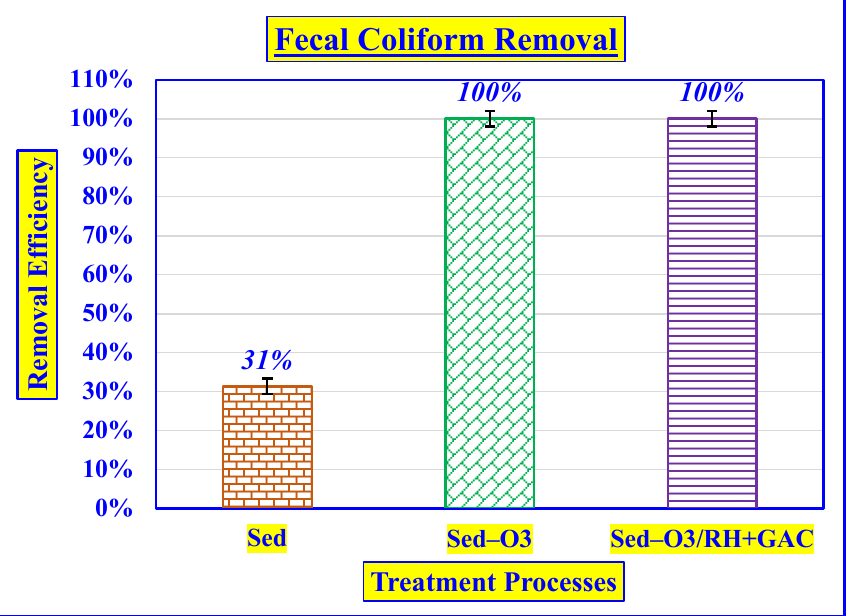
Figure 10. Fecal Coliform removal by hybrid system (Initial Fecal Coliform = 5170 MPN/100 mL; O 3 = 82.5 ± 2.2 mg/L; peristaltic pump speed = 150 rpm; C.T = 18 min; GAC = 200 g; RH = 200 g; pH = 6.9 ± 0.2; volume = 4 L; T = 25 ± 2 ◦